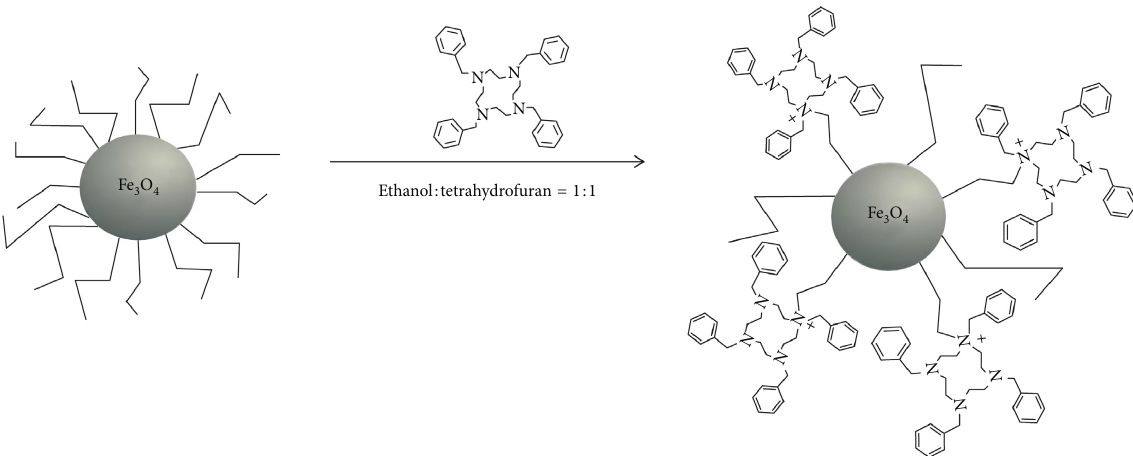
Figure 10: Preparation scheme of Fe